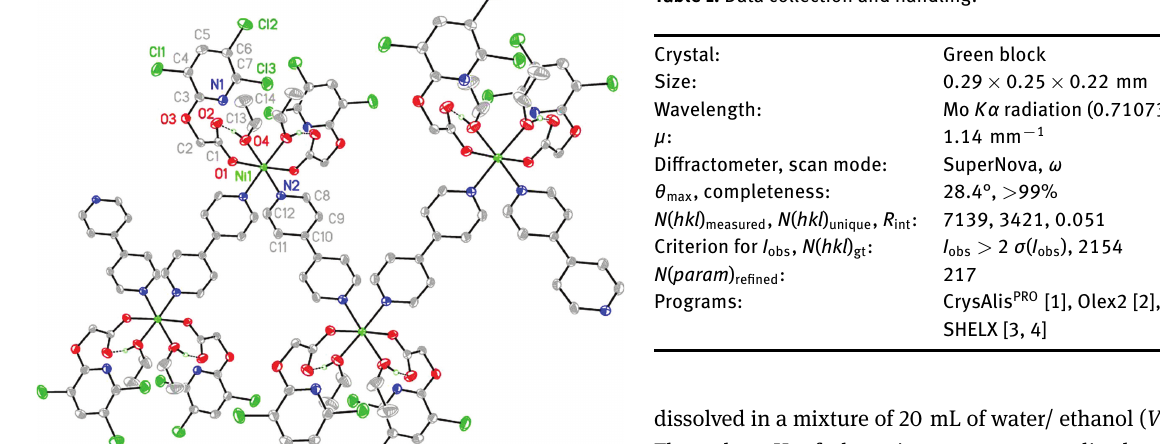
Table 1: Data collection and